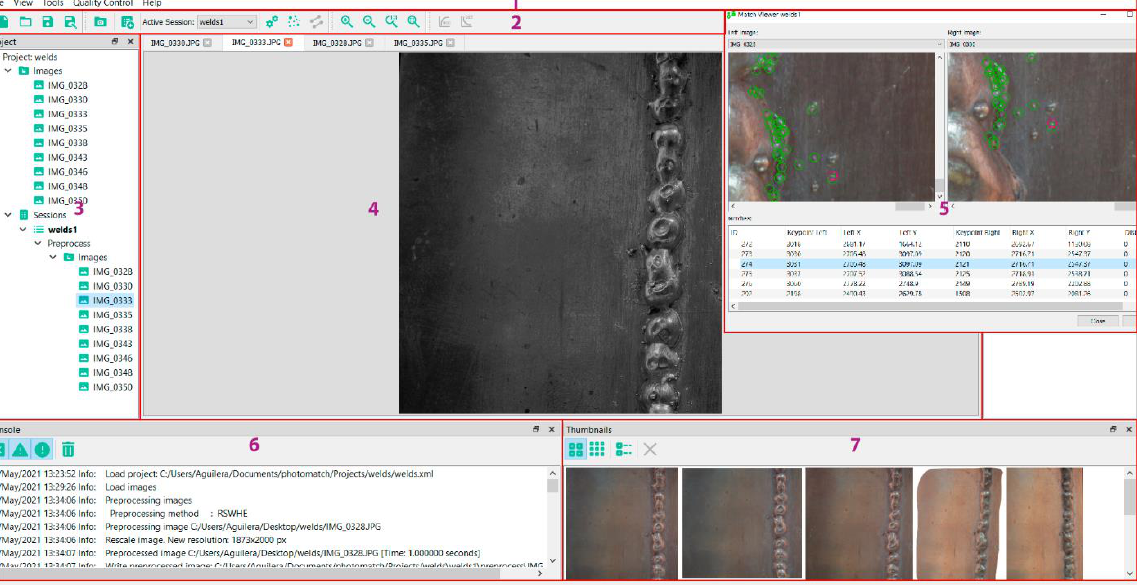
Figure 5. Feature extraction and matching in WELMAP software. In red are highlighted the different parts of the interface: menu (1), toolbar (2), tree view of the different inputs and intermediate results of the projects (3), view of the individual images (4), pop-up window with the matching results (5), console (6), and thumbnails (7).